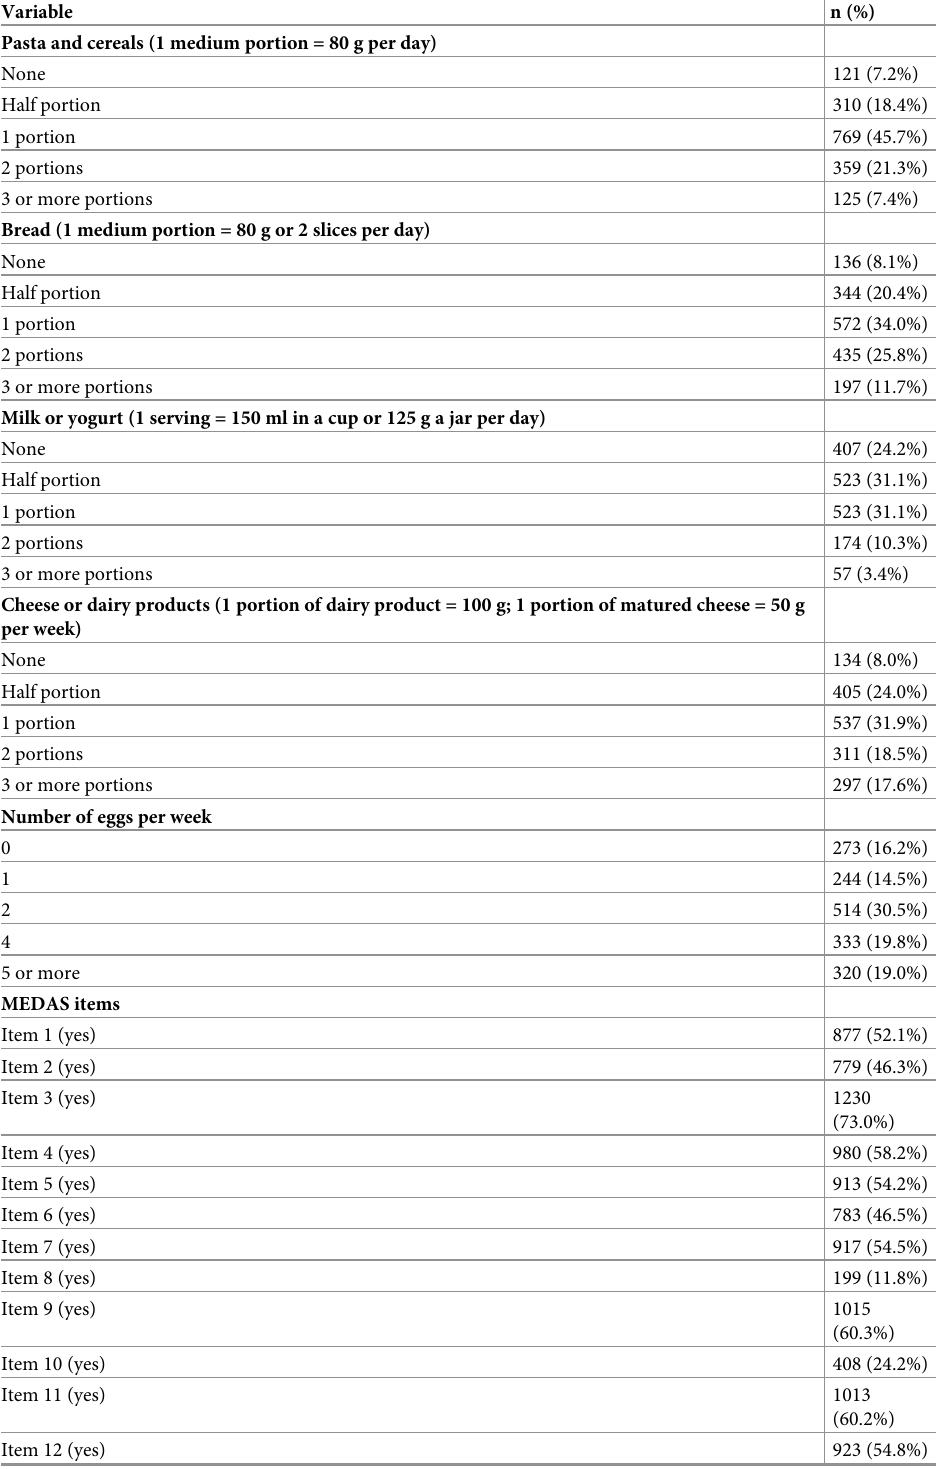
Table 2. Description of the MEDAS items and the number of portions per day of certain food items consumed during the